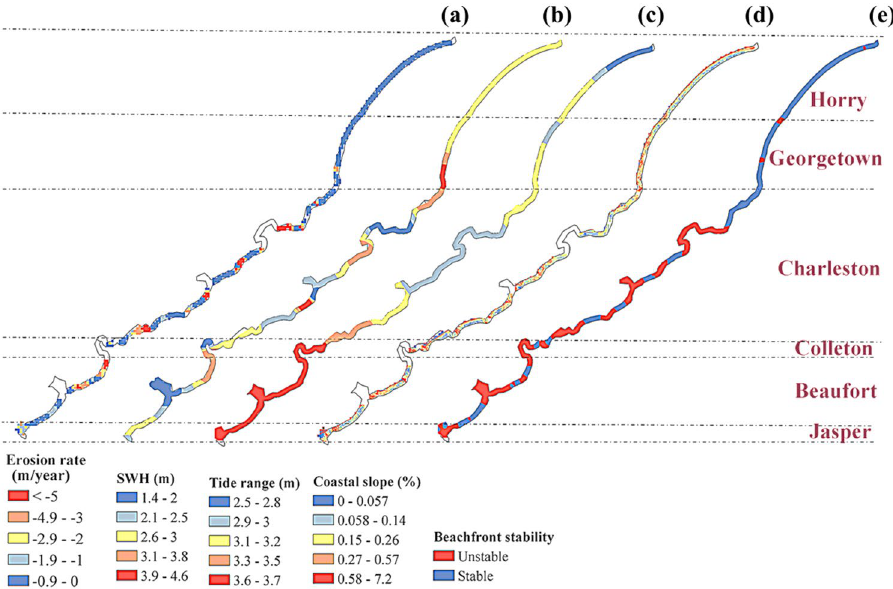
Figure 8. Shoreline vulnerability indicators of SC coast ( a ) Rate of shoreline change, ( b ) Significant wave height, ( c ) Tide range, ( d ) Coastal slope, ( e ) Beachfront stability.